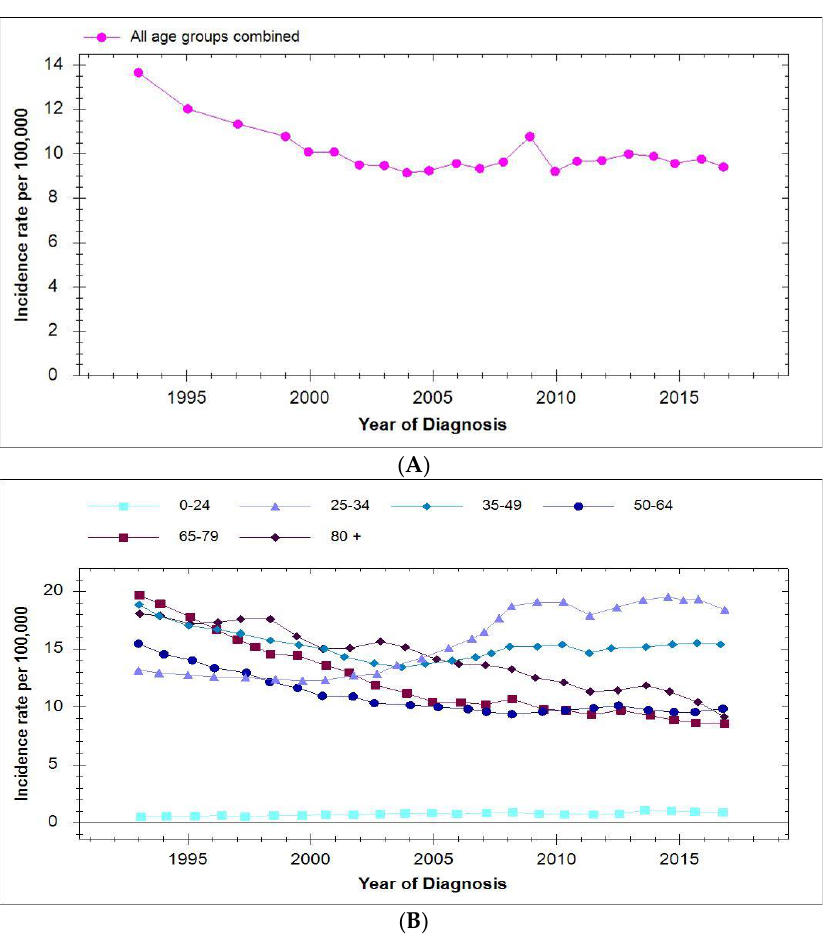
Figure 5. Incidence of invasive cervical cancer in the UK 1993 – 2017. (Source: Cancer Research UK.) ( A ) Total for all age groups; ( B ) Stratified between different age groups.